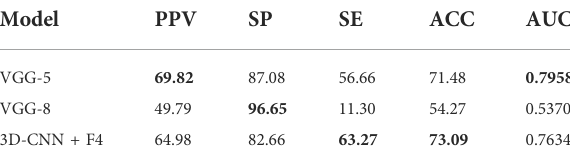
TABLE 5 Performance of up-convolution model on fi ve-fold cross-